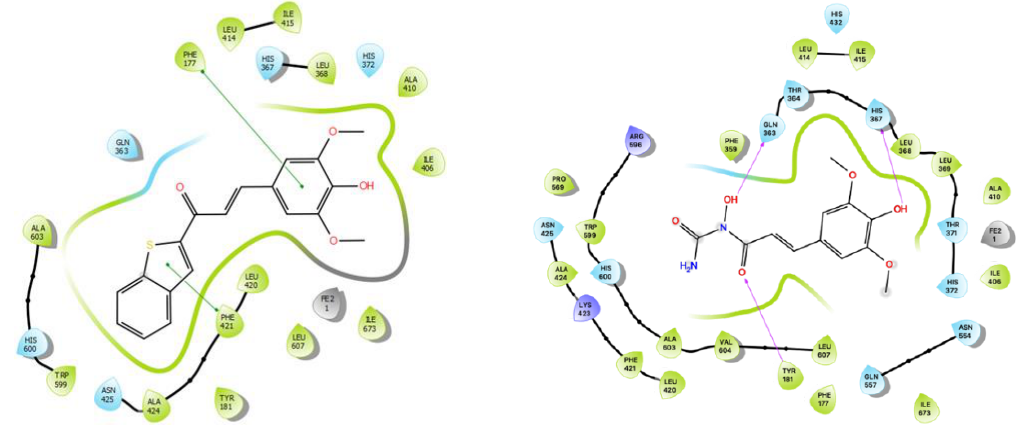
Figure 7. Visual of compound 28 (left: π – π interactions with Maestro) and compound 37 (right: hydrogen bonds with Maestro) docked with 5-LO.